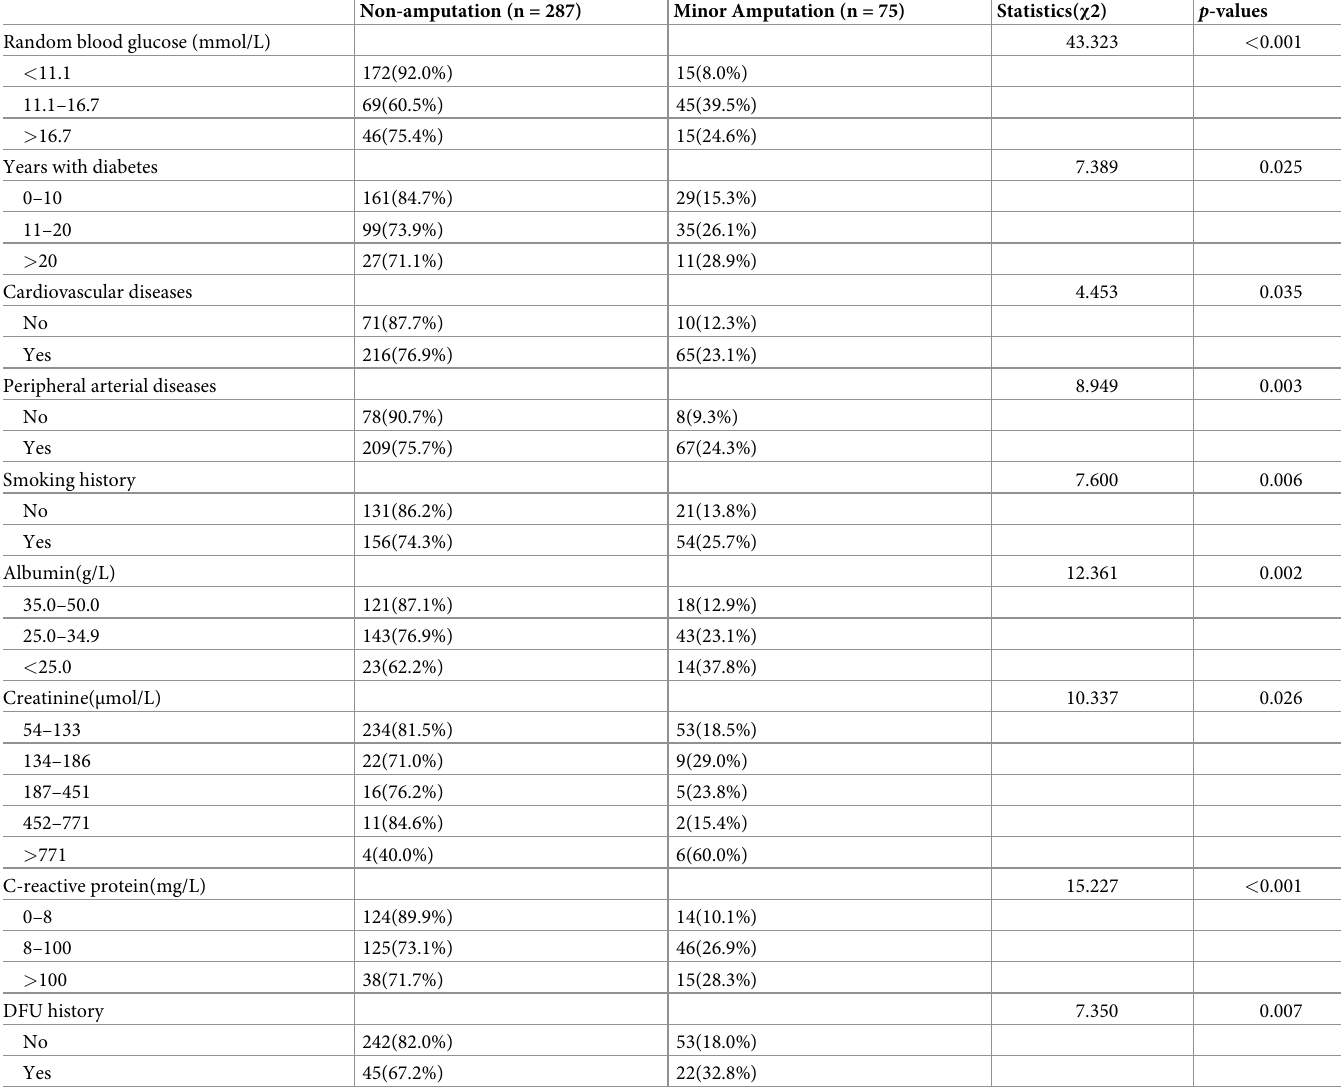
Table 2. Results of univariate analysis of minor amputation for diabetic foot ulcer patients.